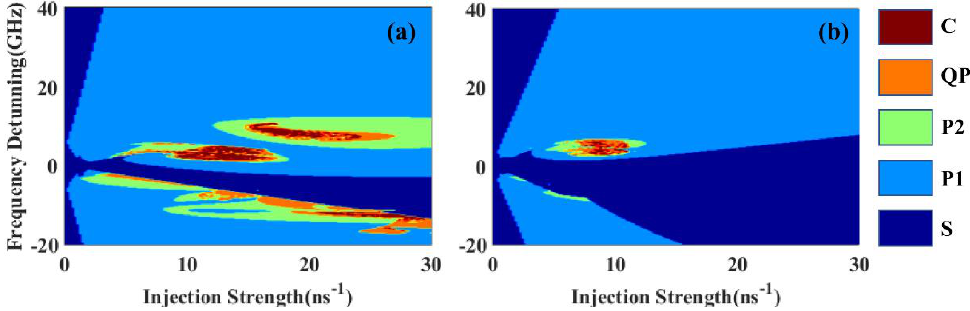
Figure 8. Numerical simulation of the dynamical maps of ( a ) the optically injected DM laser with the consideration of the nonlinear carrier recombination and ( b ) the optically injected DFB laser.